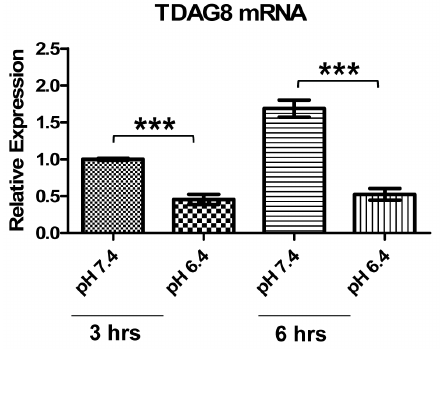
Figure 7. TDAG8 mRNA is decreased by acidosis in U937 cells. U937 cells treated with pH 7.4 or pH 6.4 for three and 6 h were subject to total RNA isolation and real-time RT-PCR using TDAG8-specific primer probes. β -actin was used as an internal control for normalization. TDAG8 expression under the 3-h pH 7.4 treatment was set as one. The data were derived from three biological replicates. Error bars indicate ±SEM. *** p <